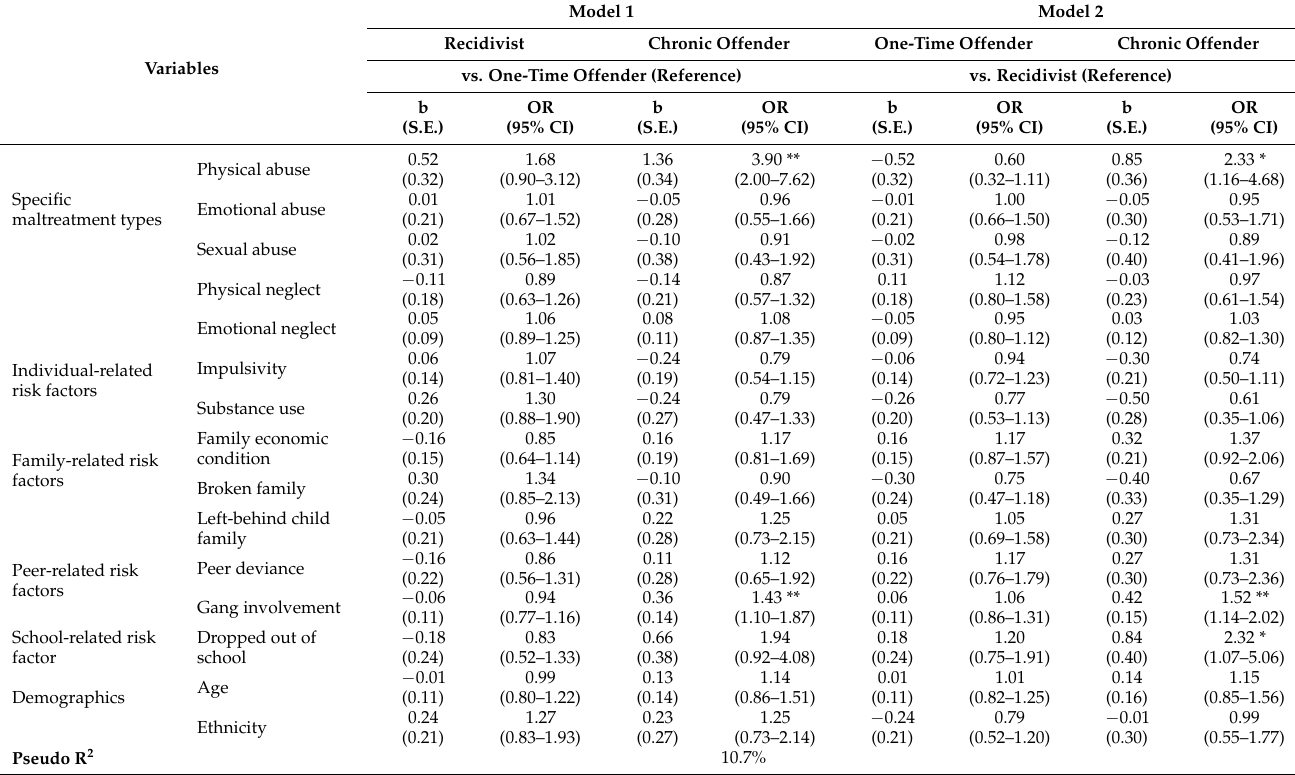
Table 4. Multinomial logistic regression results on the effect of maltreatment subtypes across offender types (N =